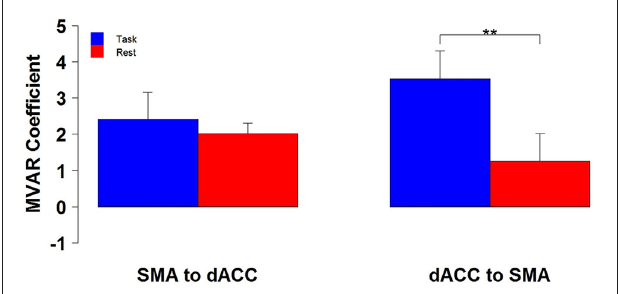
FIGURE 2 | The group mean and standard error of influence in both directions between the 2 ROIs (SMA to dACC, dACC to SMA) for Task (blue) and Rest (red) conditions . Post hoc paired t -tests revealed that the influence from dACC to SMA was significantly greater for Task than Rest, but that the influence from SMA to dACC did not significantly differ (** p < 0.01).